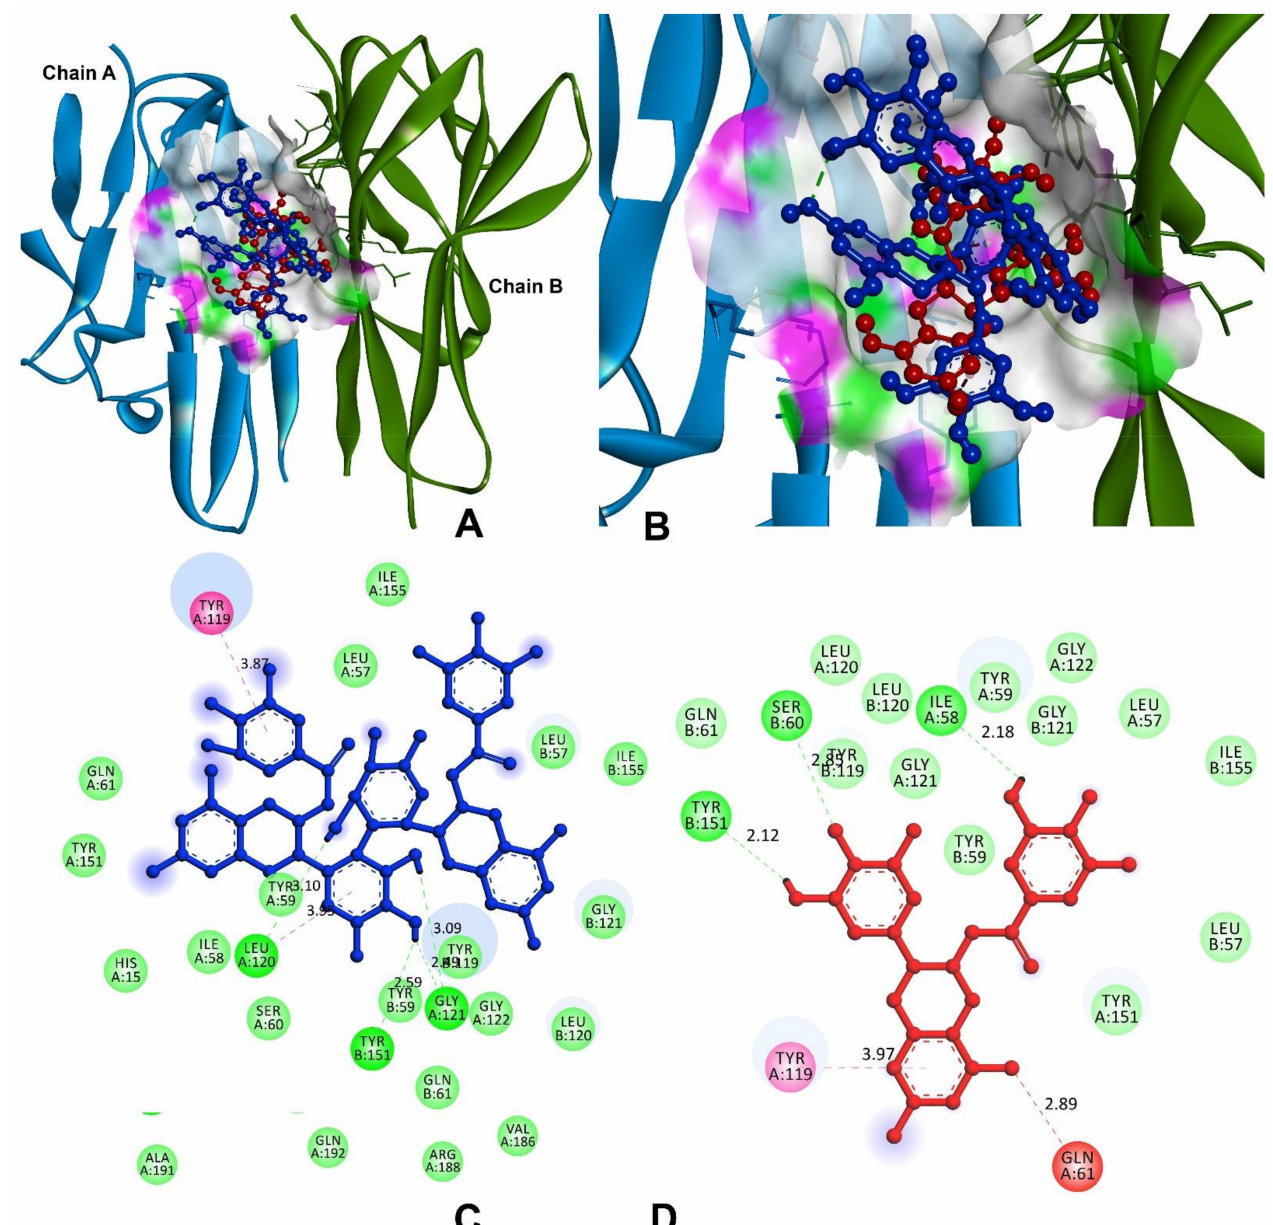
Figure 9. Molecular docking and interactions of TNF- α with theasinensin A and epigallocatechin gallate. ( A ) Chain-A ( Cyan ) and chain-B ( green ) of TNF- α bound with compounds of theasinensin A ( blue ) and epigallocatechin ( red ). ( B ) Higher magnification of theasinensin A ( blue ) and epigal- locatechin gallate ( red ) with TNF- α . ( C ) Molecular interactions of IL-1 and theasinensin A ( blue ). ( D ) Molecular interactions of TNF- α and epigallocatechin ( red